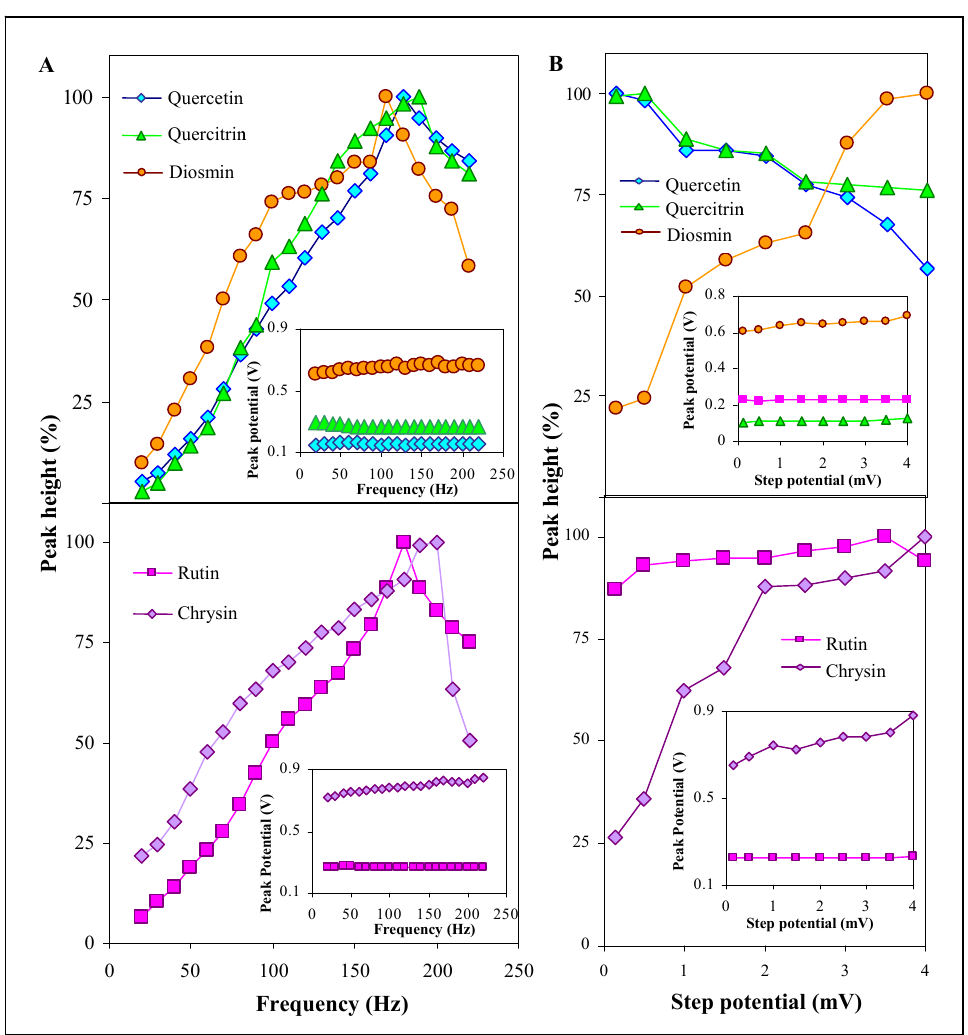
Figure 3. Influence of different frequencies ( A and inset ) and step potentials ( B and inset ) on peak heights and potentials of the flavonoids. For other details see Figure